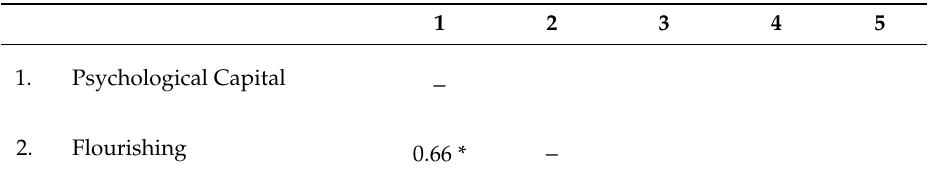
Table 1. Correlation matrix and descriptive statistics (mean, standard deviation, asymmetry, and kurtosis) for the study